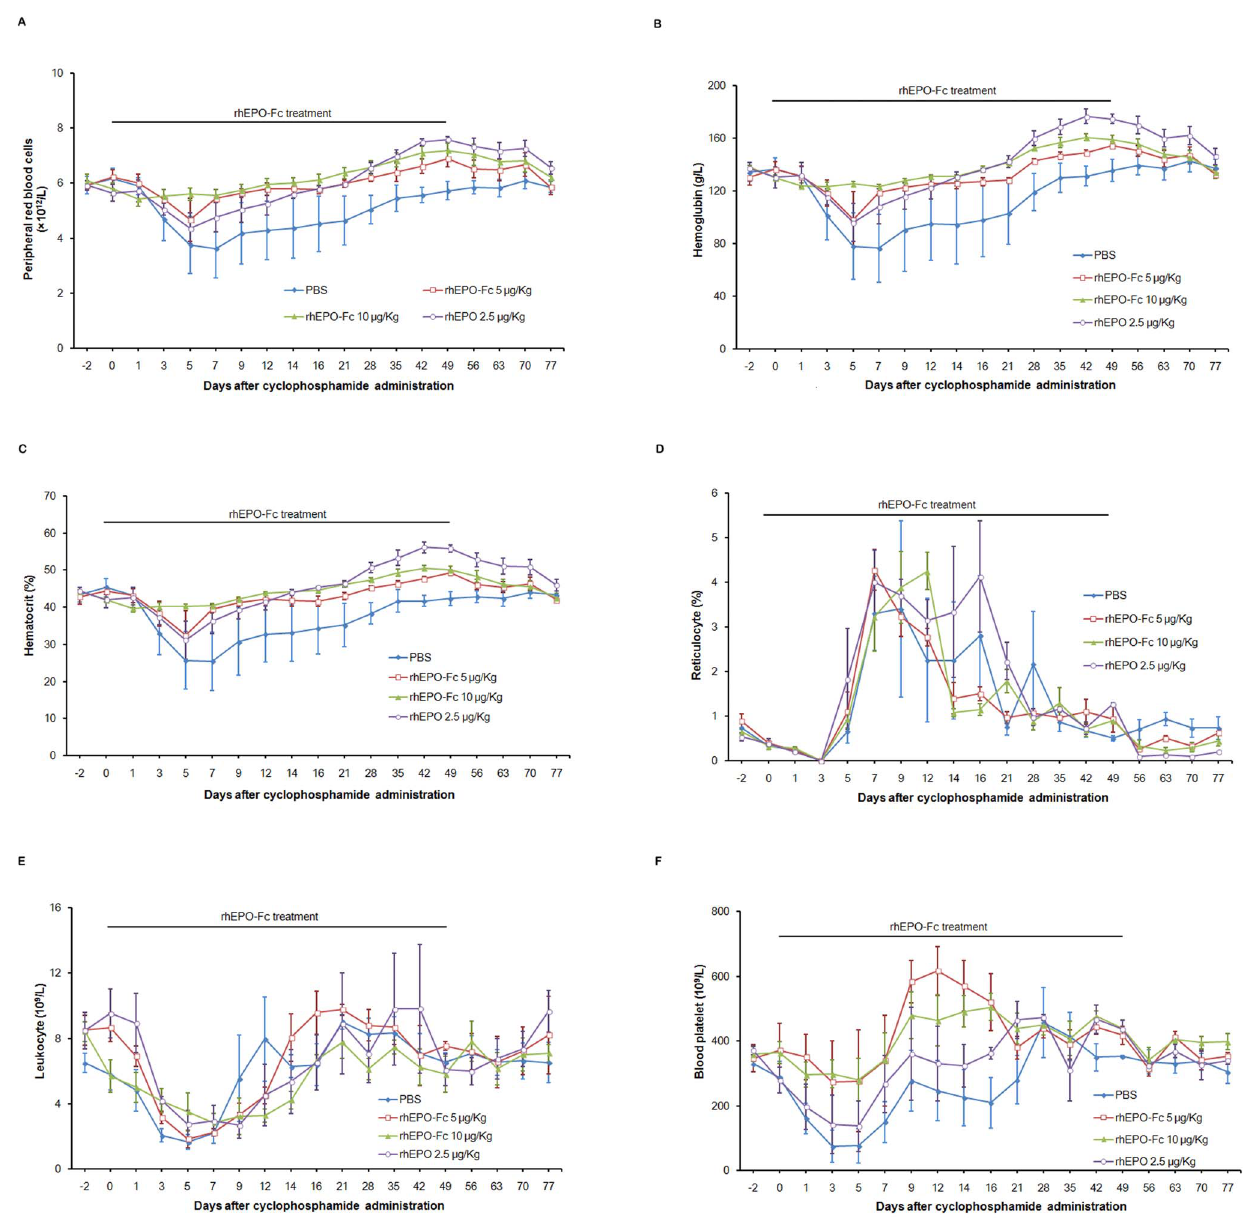
Figure 4. rhEPO-Fc attenuated anemia induced by cyclophosphamide in rhesus monkeys. Blood samples were collected at 0–49 days during treatments and additional 2 times weekly after the treatment ended. RBC (Fig. 4A), hemoglobin (Fig. 4B), hematocrit (Fig. 4C), reticulocyte (Fig. 4D), leukocyte (Fig. 4E) and blood platelet (Fig. 4F) were determined. Data were presented as Mean 6 SD.